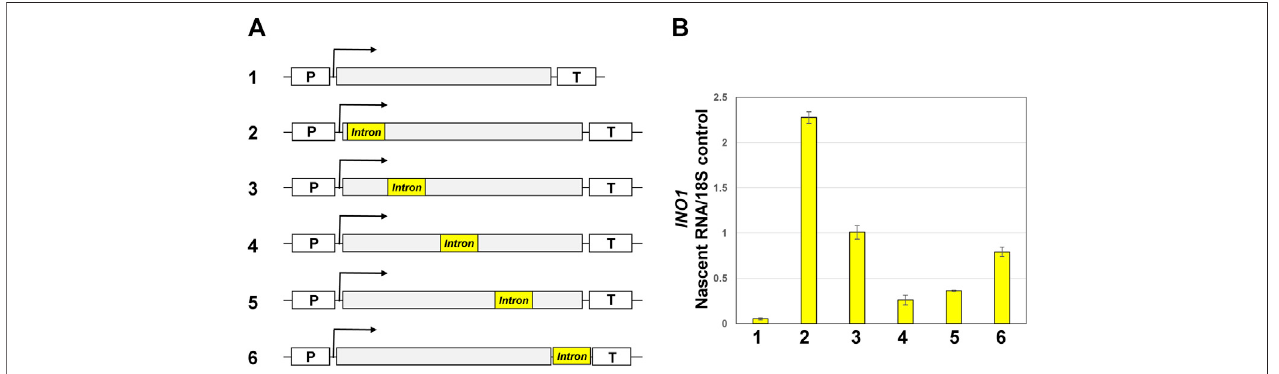
FIGURE 3 | Position of the intron in INO1 gene in fl uences the transcription of the gene. (A) Schematic representation of INO1 gene without intron (1) and with the ACT1 intron insertedat fi vedifferentpositionsalongthe bodyofthegene(2 – 6). “ p ” and “ T ” stand forthepromoter andterminator respectively. (B) Quanti fi cation ofTRO dataof INO1 geneintheabsenceofanintron(#1)andthepresenceofanintronat100 bpposition(#2),500 bp(#3),800 bp(#4),1,400 bp(#5),and10 bpdownstream of (TGA + 10) (#6). The transcript levels of 18S were used as the normalization